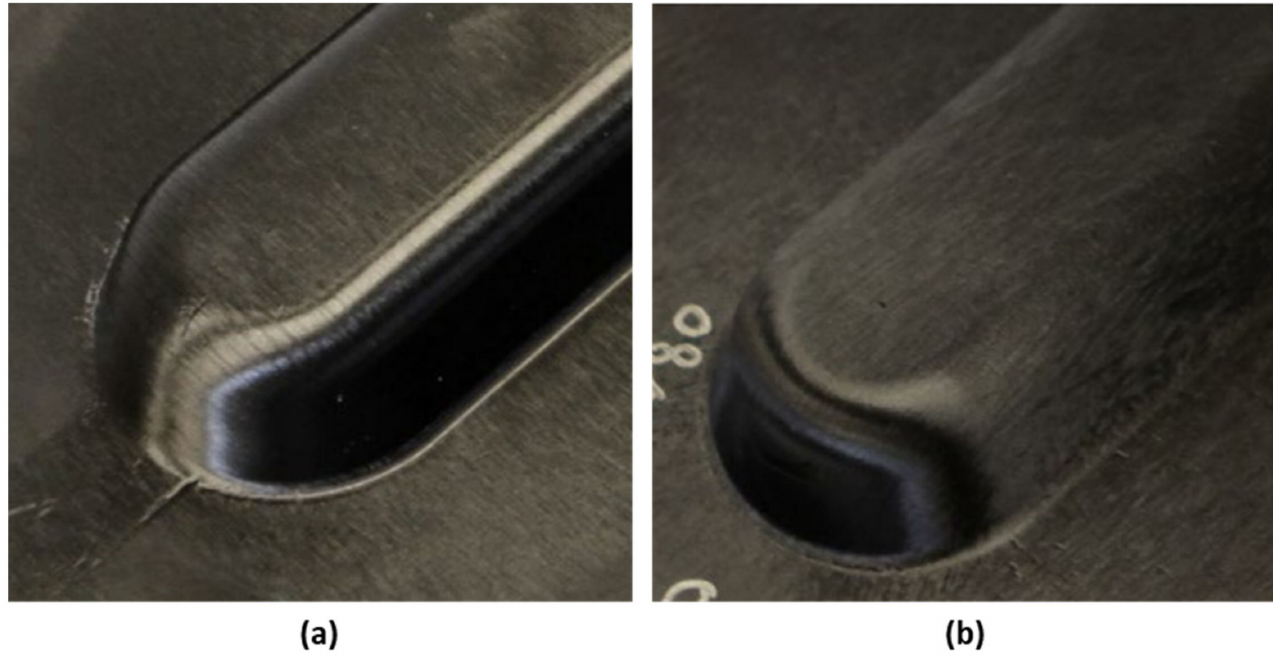
Figure 16. Formability of TUFF composites in the ( a ) longitudinal and ( b ) transverse directions. Reprinted with permission from [91]. Copyright 2019